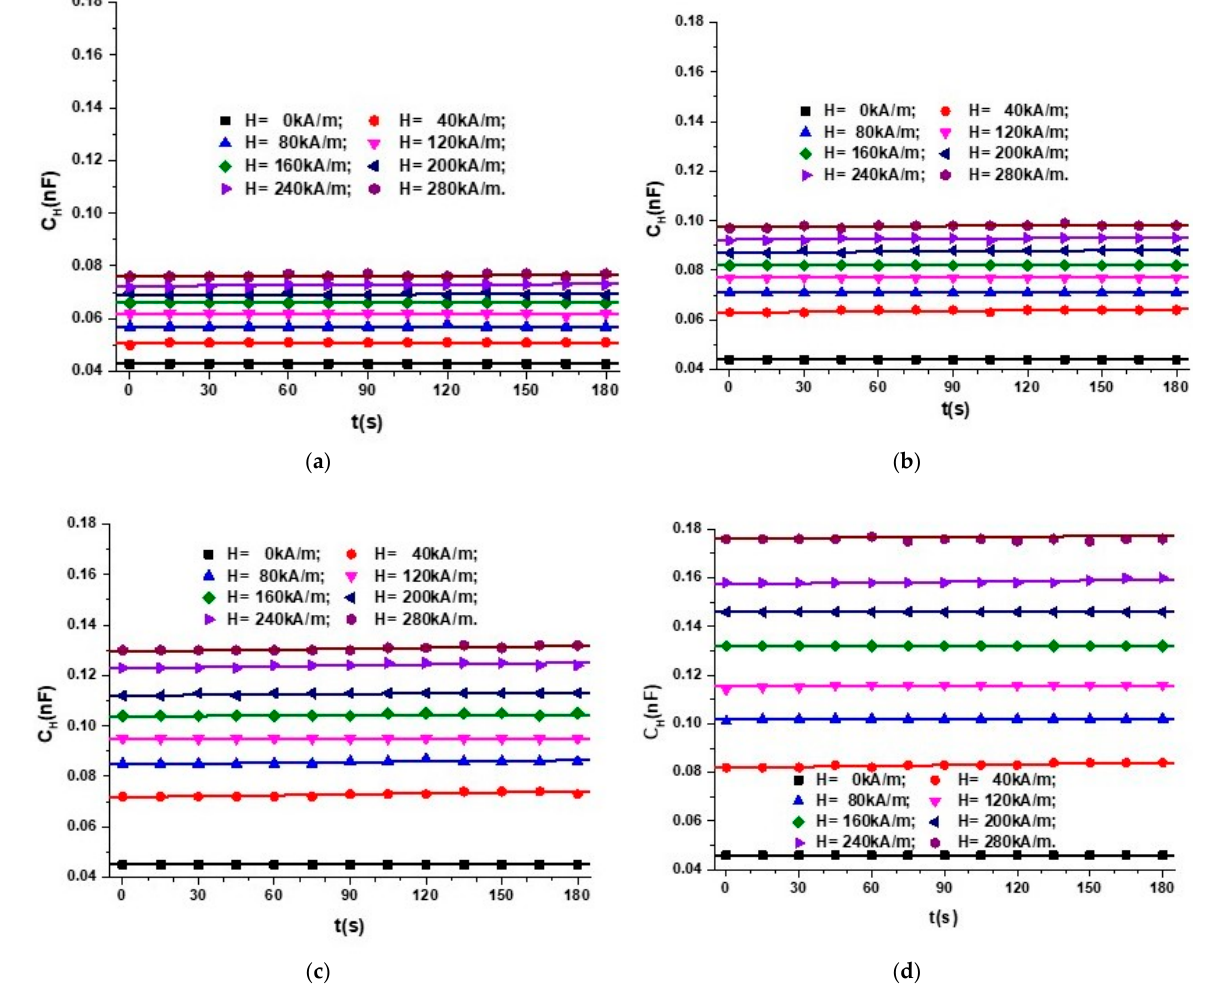
Figure 13. The electrical capacity of MTS, C (cid:2892) , as a function of time and intensity of the magnetic field applied on the direction of the deformation force: ( a ) F = 0 N; ( b ) F = 1 N; ( c ) F = 2 N; ( d ) F = 3 N.